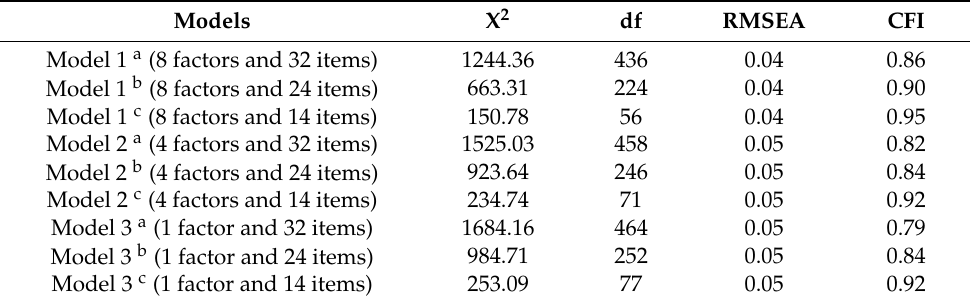
Table 1. Fit indices of the models for moral disengagement (MD). Models X 2 df RMSEA